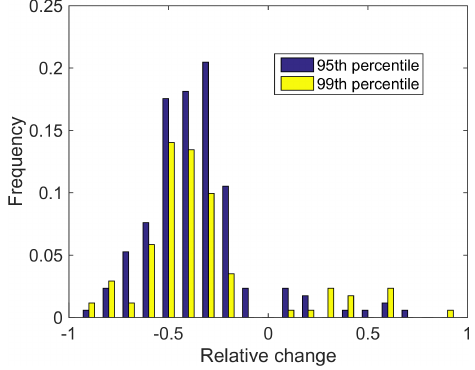
Figure 5. Histogram of the relative changes in the 95th and 99th percentiles estimated from the quantile regression models, with time as covariate (with a slope significantly different than zero at the 10%